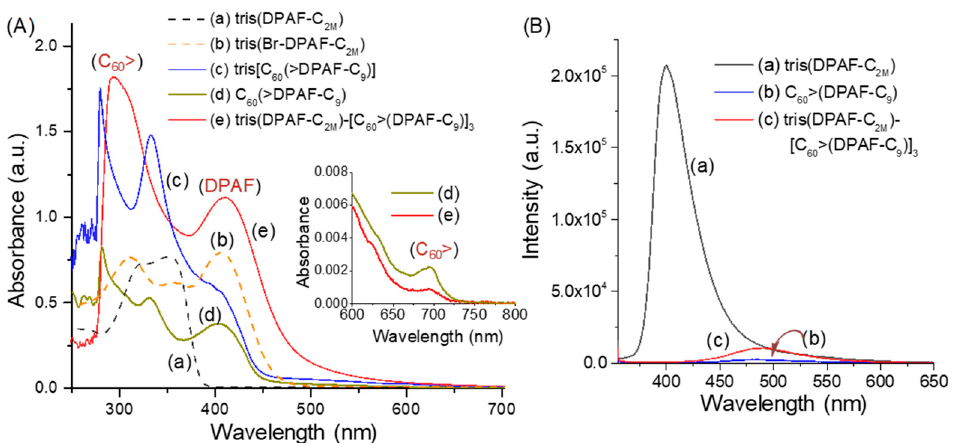
Figure 4. UV-vis spectra of ( A ) (a) tris(DPAF-C 2M ) ( 2 -C 2M ), (b) tris(BrDPAF-C 2M ) ( 3 -C 2M ), (c) cis - cup - tris[C 60 (>DPAF-C 9 )], (d) C 60 (>DPAF-C 9 ) ( 1 -C 9 ), and (e) cis - cup - 4 -C 2M ‒ 9 , where (a), (b), and (e) were